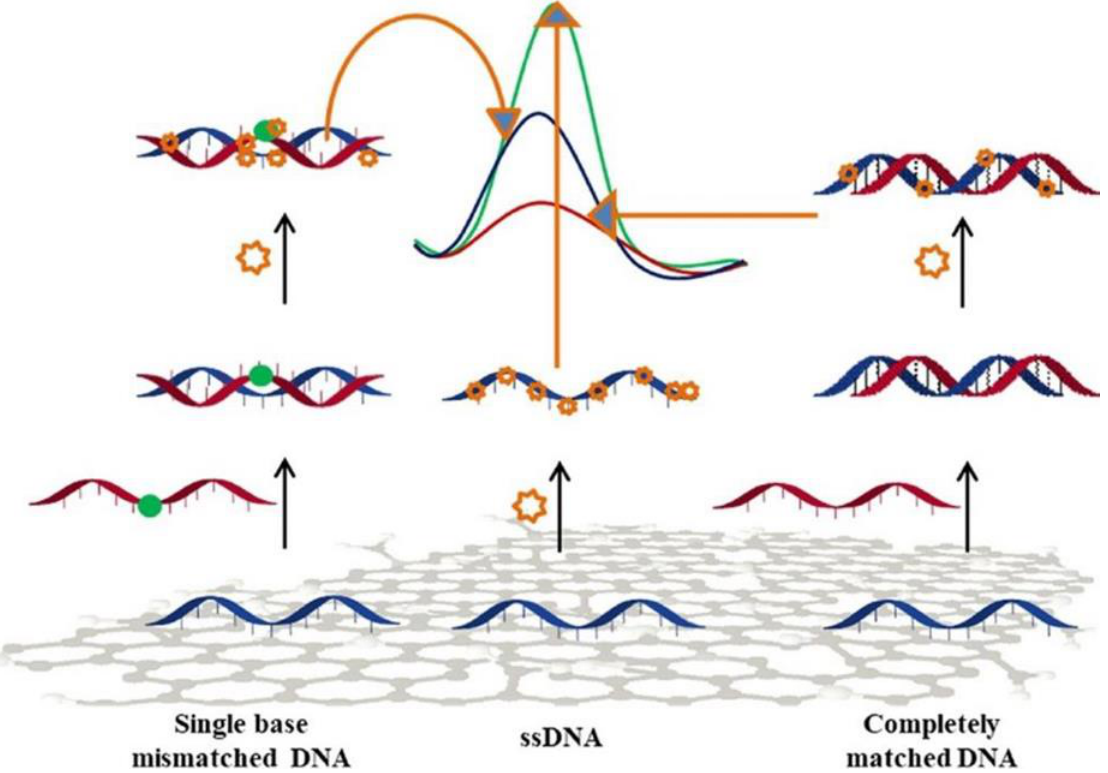
Figure 9. Scheme of the DPV signal of MoS 2 -polyaniline sensors with completely matched and single base mismatched DNA. Reprinted with permission from reference [90]. Sensors 2020 , 20 , x